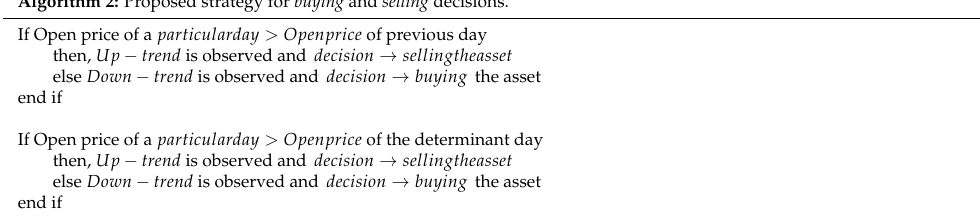
Algorithm 2: Proposed strategy for buying and selling